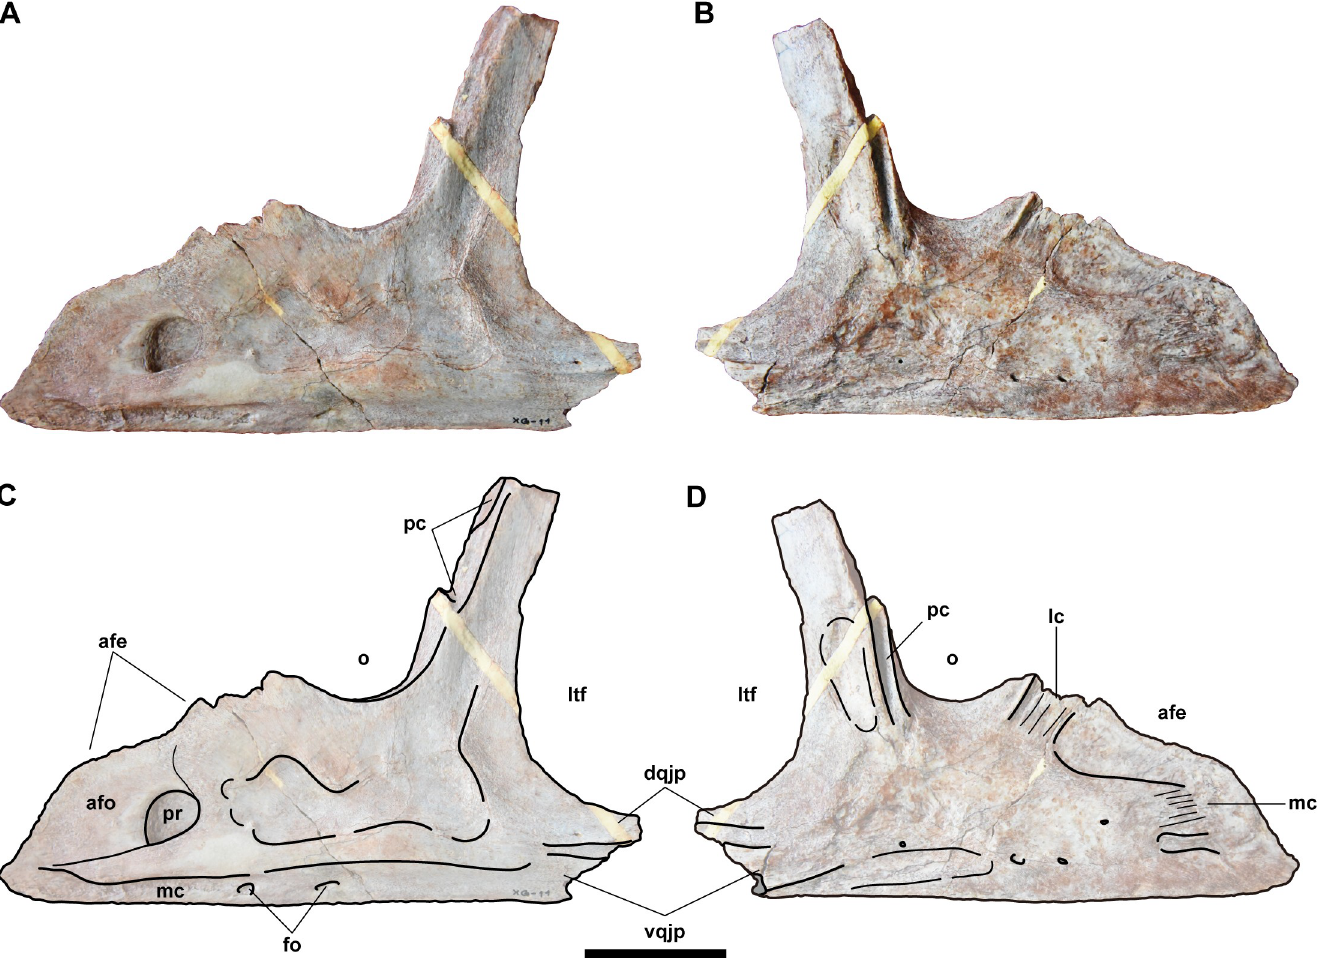
Fig 5. Left jugal (NRRU-F01020006) in lateral and medial views. Abbreviations: afe, antorbital fenestra; afo, antorbital fossa; dqjp, dorsal quadratojugal prong; fo, foramen; lc, lacrimal contact; ltf, lateral temporal fenestra; mc, maxilla contact; o, orbit; pc, postorbital contact; pr, pneumatic recess; vqjp, ventral quadratojugal prong. Scale bar equals 20